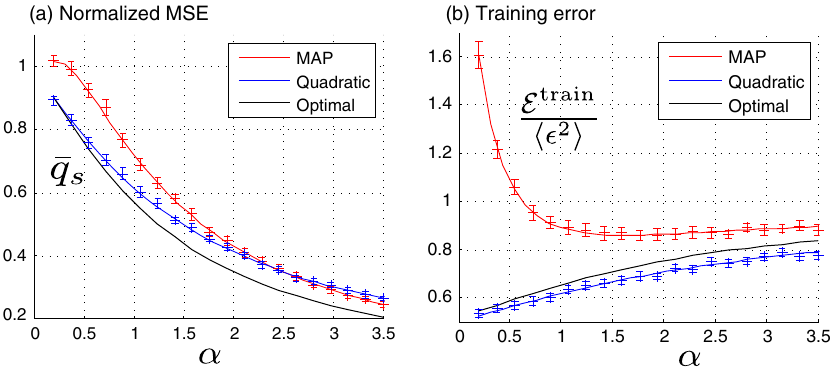
FIG. 6. Regularized inference for Laplacian noise and signal E ϵ ¼ j ϵ j , E s ¼ j s 0 j . (a) The normalized MSE, or fraction of unexplained variance ¯ q s . (b) The training error. Each plot shows the respective performance of three different inference procedures: our optimal inference (28), (29) (black), MAP inference (red), and optimal quadratic inference (blue). The theoretical predictions (solid curves) match numerical simulations (error bars), which reflects the standard deviation calculated over 20 trials using a convex optimization solver for randomly generated, finite-sized data (with N and P varying while N ¼ α P and significantly outperform common but suboptimal methods. For example, to achieve a fraction of unexplained variance of 0.4, optimal inference requires a measurement density of α ≈ 1 . 7 , while quadratic and MAP inference require α ≈ 2 . 1 and α ≈ 2 . 2 , respectively. This reflects a reduction of approximately 20% in the amount of required